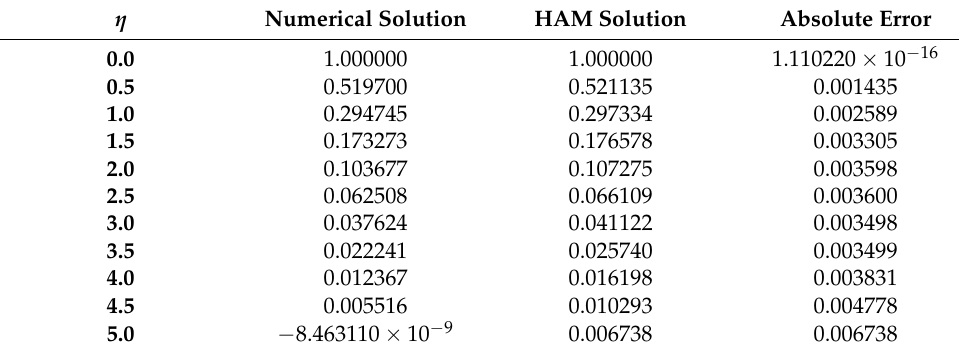
Table 1. Numerical solution via analytical solution for velocity profile.